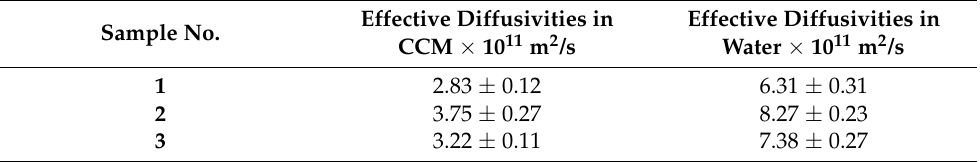
Table 6. Effective glucose diffusivities through membrane in water and CCM at 37 ◦ C. Sample No.